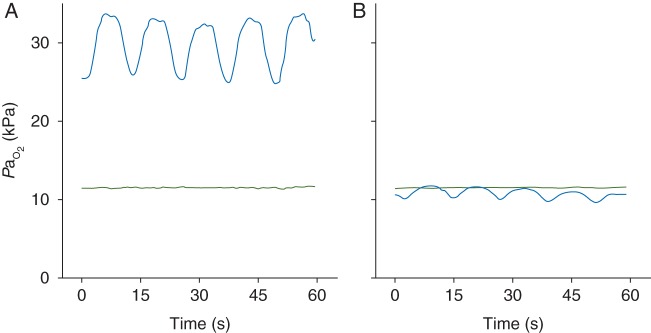
Continuous recordings of PaO2 for a period of about 1 min in a healthy ovine lung (green line) and after saline lavages (blue line); the inspired oxygen fraction was 30% and 100%, respectively. PaO2 values are shown for (a) mild and (b) severe ARDS-like conditions. Respiratory rate was 5 bpm in each experiment. PaO2 oscillations with the same period as breathing were detected in each ARDS model.